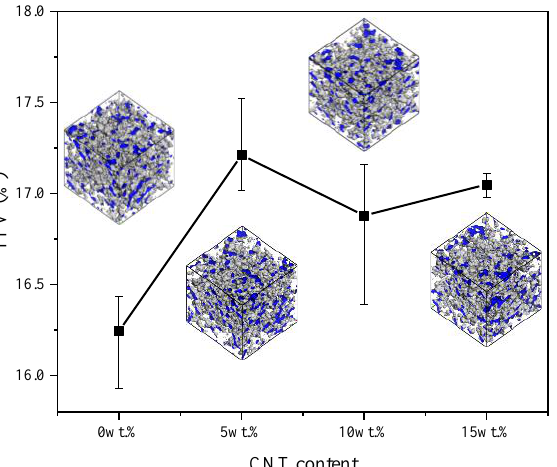
Figure 6. The FFVs and free volume distribution of different CNT contents CNT/VNR composites.